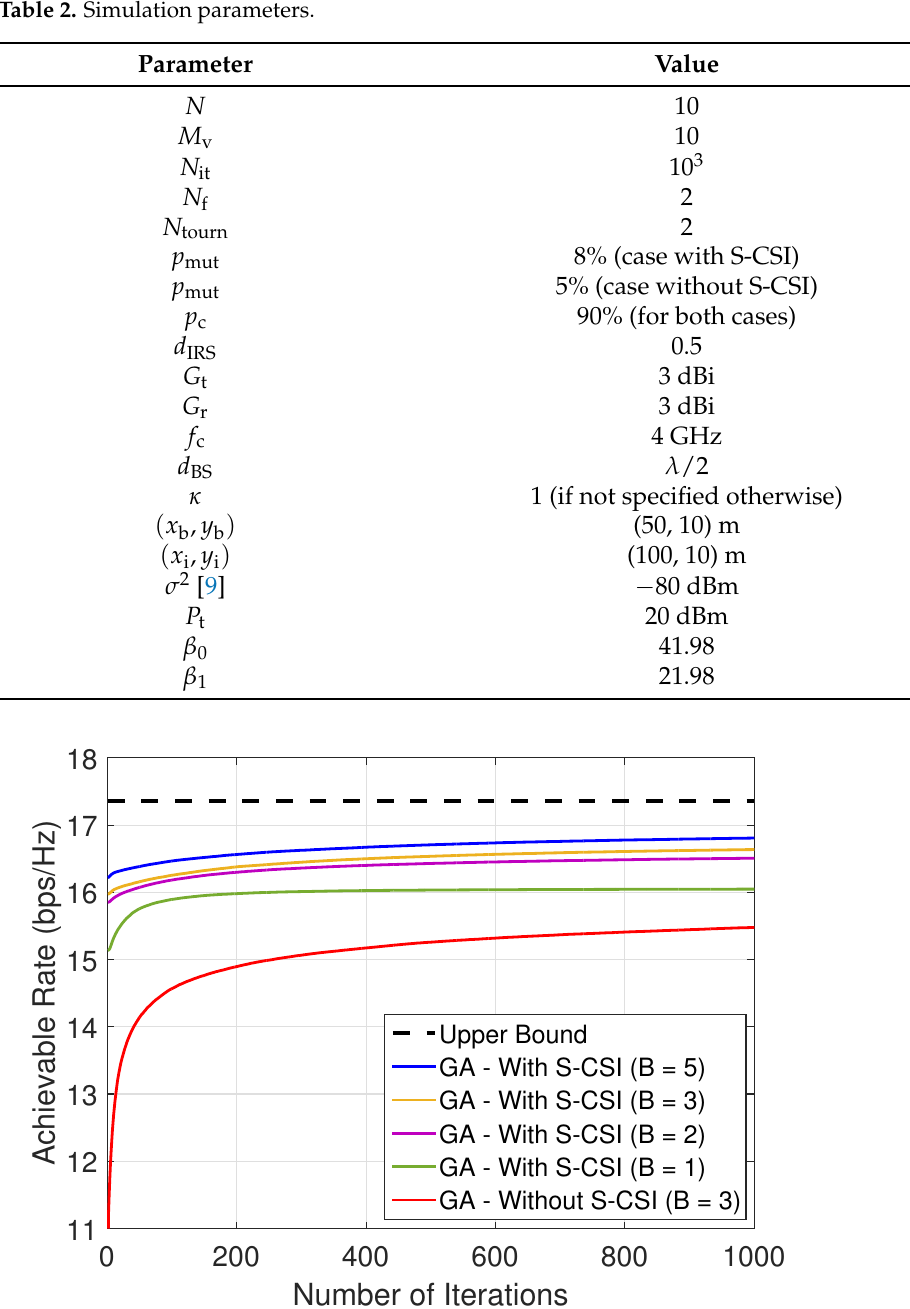
Figure 4. Analysis of the number of controlling bits at each element at the IRS with and without CSI knowledge considering M = 40 and ( x u , y u ) = ( 95,8 ) m, i.e., d IU ∼ 5